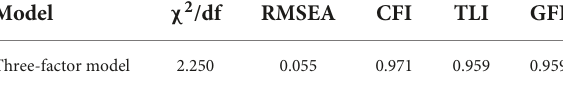
TABLE 4 Model fit indices for the model in the study.